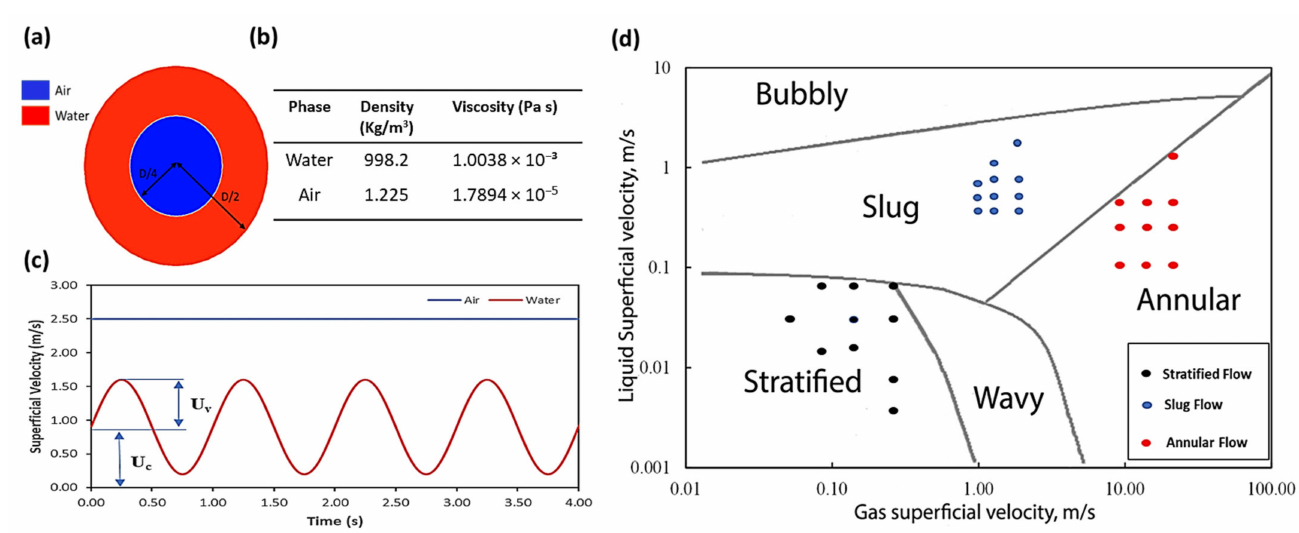
Figure 4. Boundary conditions. ( a ) Cross section of the water and air inlet. ( b ) Working medium physical properties (at 20 ◦ C). ( c ) Air and water superficial velocity graph at the inlet for slug flow. ( d ) Superficial velocities used for simulation